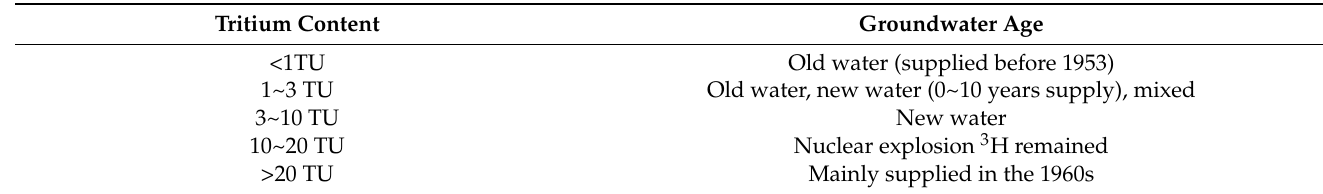
Table 1. Qualitative age judgment of tritium content in groundwater.